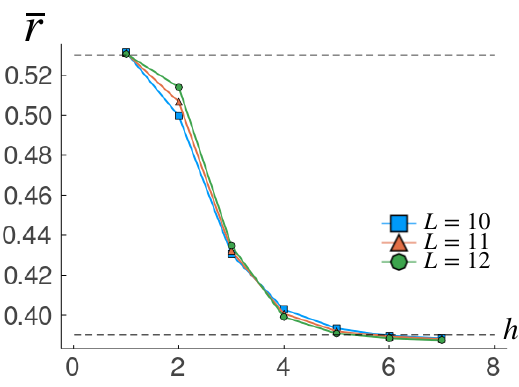
Figure 14: The gap ratio statistics r for various disorder strengths h and system sizes L . Note that the dashed lines corresponding to the mean values from a Gaussian orthogonal ensemble ( r ≈ 0.53) and a Poisson ensemble ( r ≈ 0.39). We therefore see that the system is in the MBL regime when h (cid:166) 3.